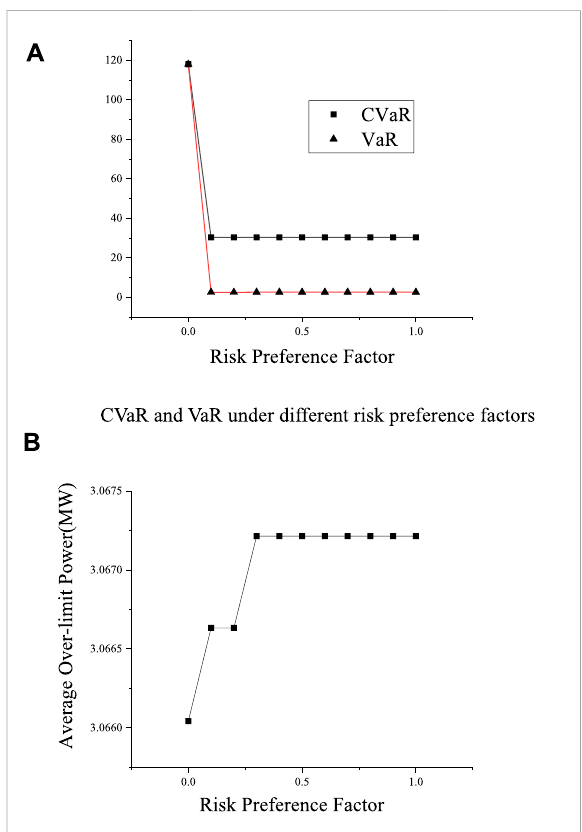
FIGURE 11 Solution results under different risk preference factors. (A) CVaR and VaR under different risk preference factors (B) Average over-limit power under different risk preference